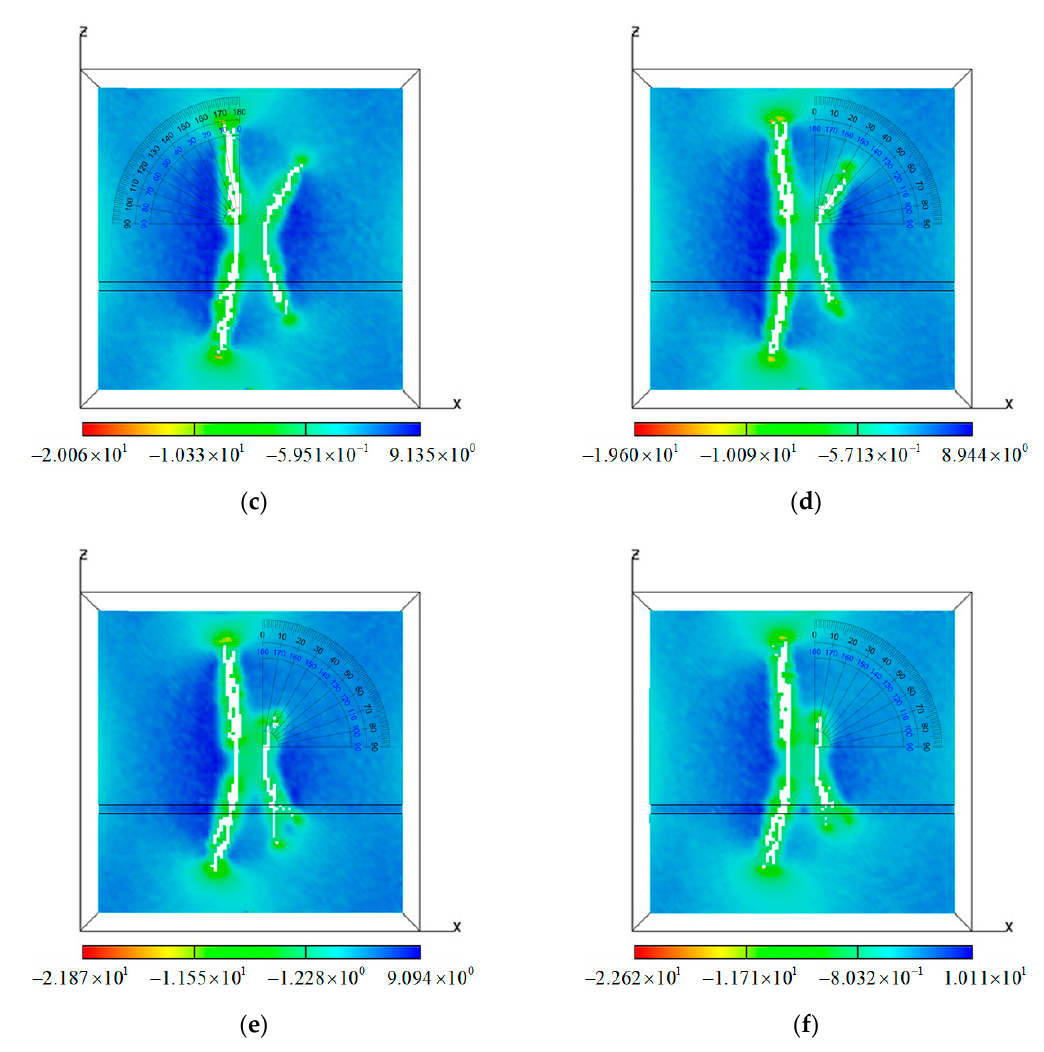
Figure 9. The minimum compressive principal effective stress (MPa) of models with different interlayer Poisson’s ratio at t = 2000 s: ( a ) Multi-Po1, v 1 / v 0 = 0.5; ( b ) Multi-Po2, v 2 / v 0 = 0.75; ( c ) Multi-00, v 0 / v 0 = 1.0; ( d ) Multi-Po3, v 3 / v 0 = 1.25; ( e ) Multi-Po4, v 4 / v 0 = 1.5; ( f ) Multi-Po5, v 5 / v 0 = 2.0.